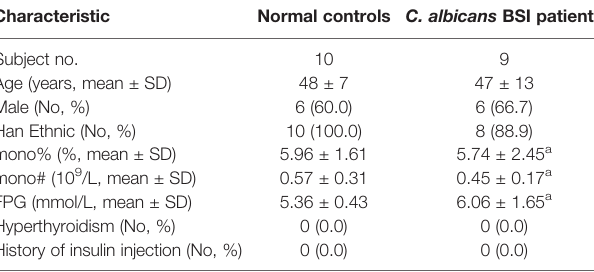
TABLE 1 | Demographic and clinical characteristics of